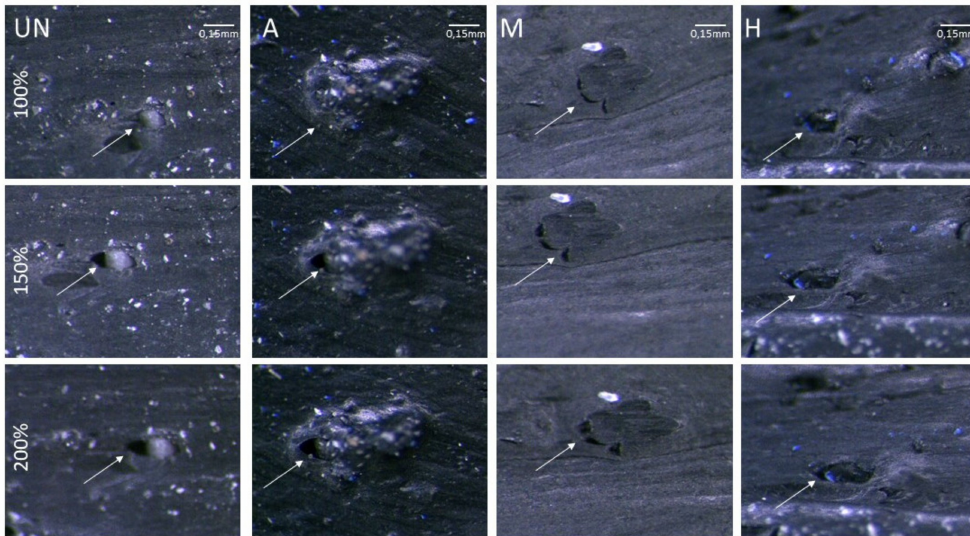
Figure 11. Microscopic picture of fractured samples containing untreated GTR (UN5) and GTR after acid activation (A5), silane modification (M5), and hybrid treatment (H5). Arrows indicate on the holes created between GTR particles and polymer